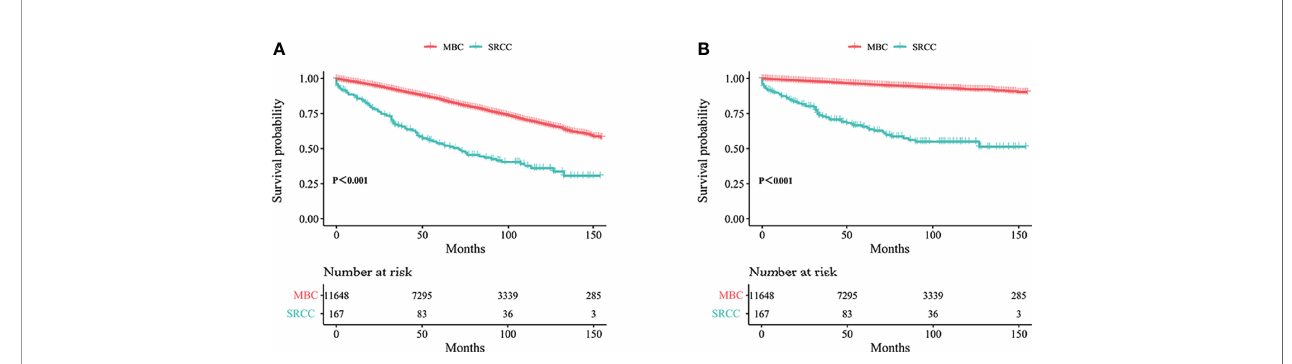
FIGURE 1 | Kaplan – Meier curves: OS (A) and BCSS (B) among SRCC and MBC before PSM. OS, overall survival; BCSS, breast cancer-speci fi c survival; SRCC, primary breast signet ring cell carcinoma; MBC, mucinous breast adenocarcinoma; PSM, Propensity Score